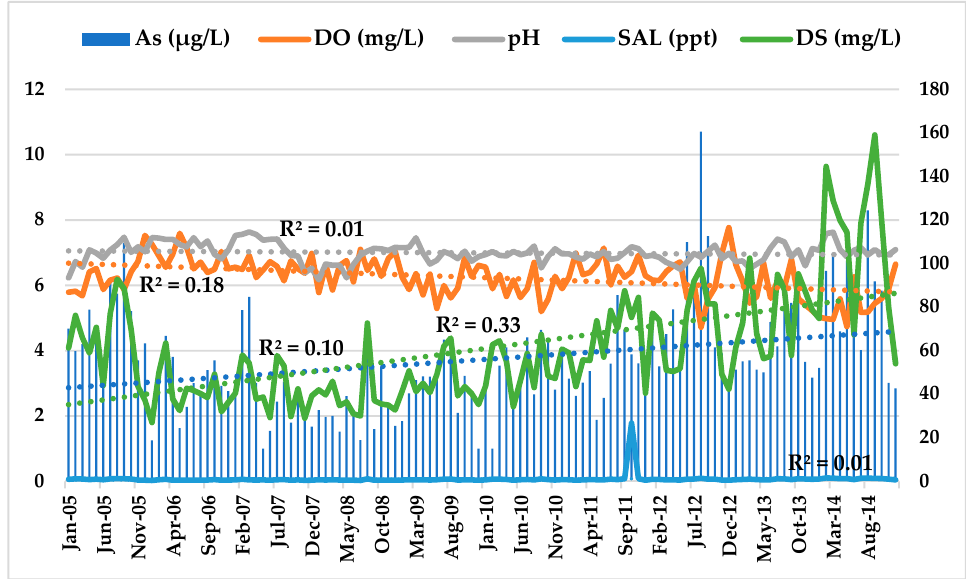
Figure 4. As ( μ g/L) concentration from 2005 to 2014 in the Langat River. Figure 4. As ( µ g/L) concentration from 2005 to 2014 in the Langat